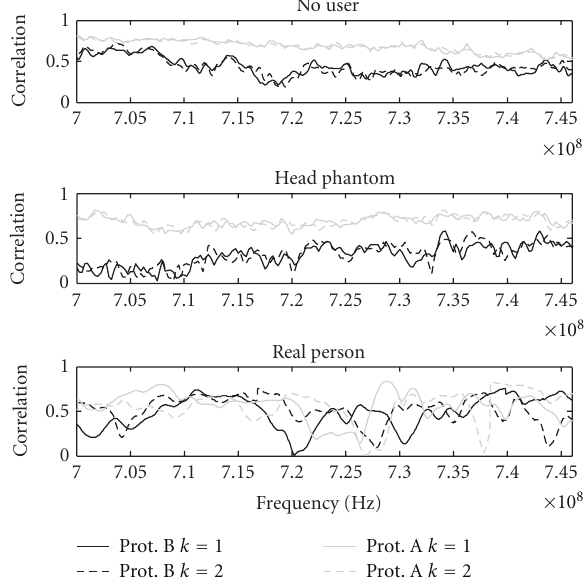
Figure 3: Correlation of the 700 MHz band devices for the three di ff erent scenarios.